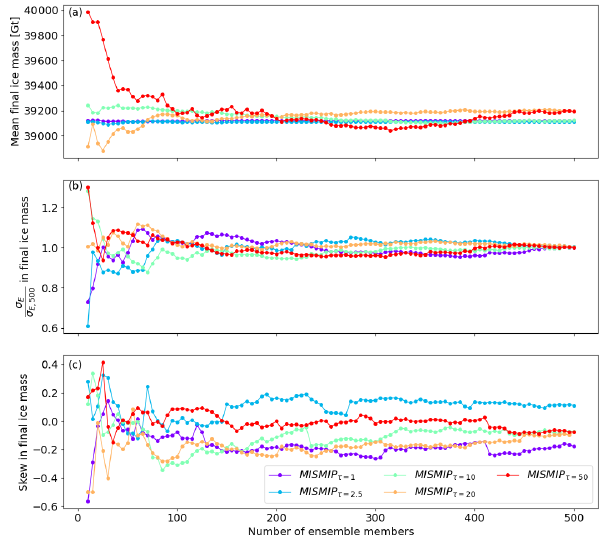
Figure C1. Convergence of the (a) mean, (b) standard deviation, and (c) skew in final ice mass for the MISMIP+ transient ensembles as a function of number of ensemble members. For (b) , we show the standard deviation relative to the standard deviation of the full ensemble with 500